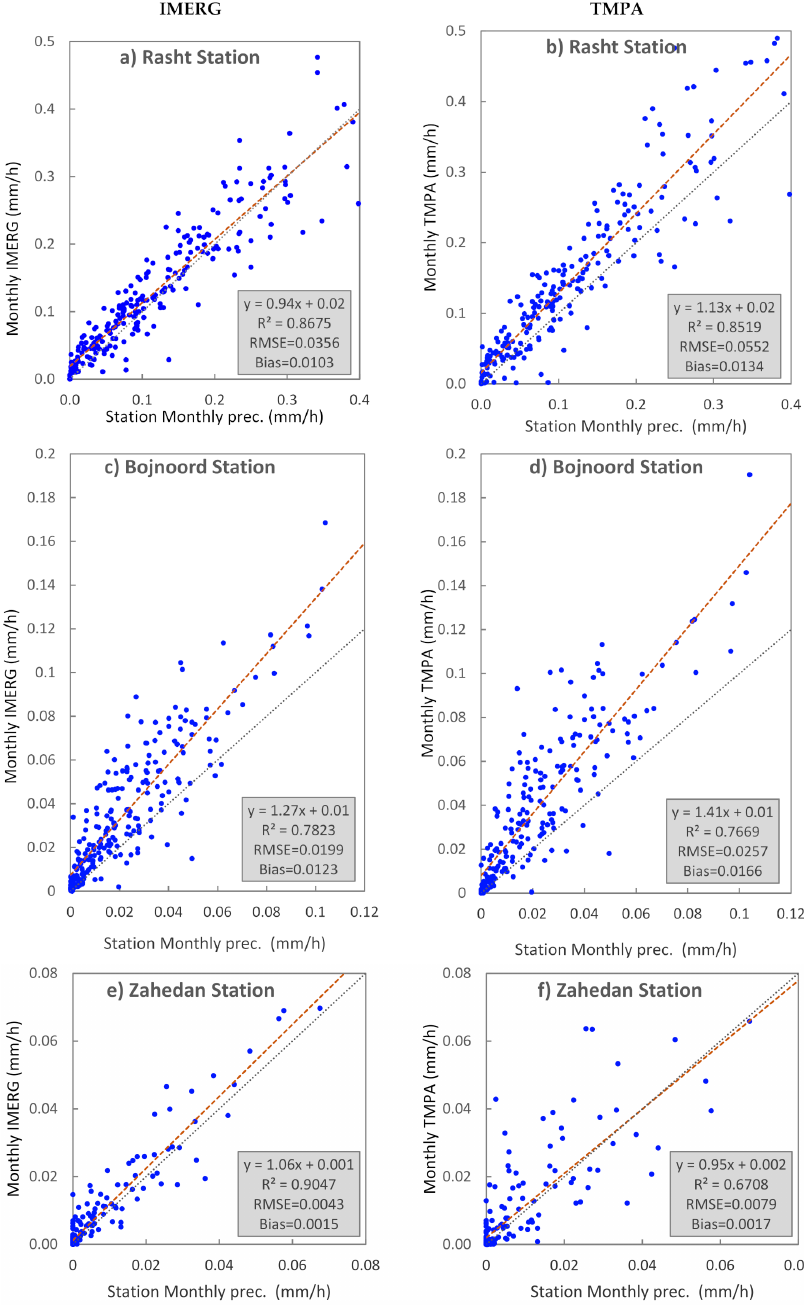
Figure 4. Comparison of monthly average precipitation between stations and satellite data for ( a , b ) Rasht (humid and rainy) ( c , d ) Bojnoord (semi-arid), and ( e , f ) Zahedan (arid). Red and black dashed lines show the trend line, and x = y line, respectively. The stations used here are marked by red points in Figure